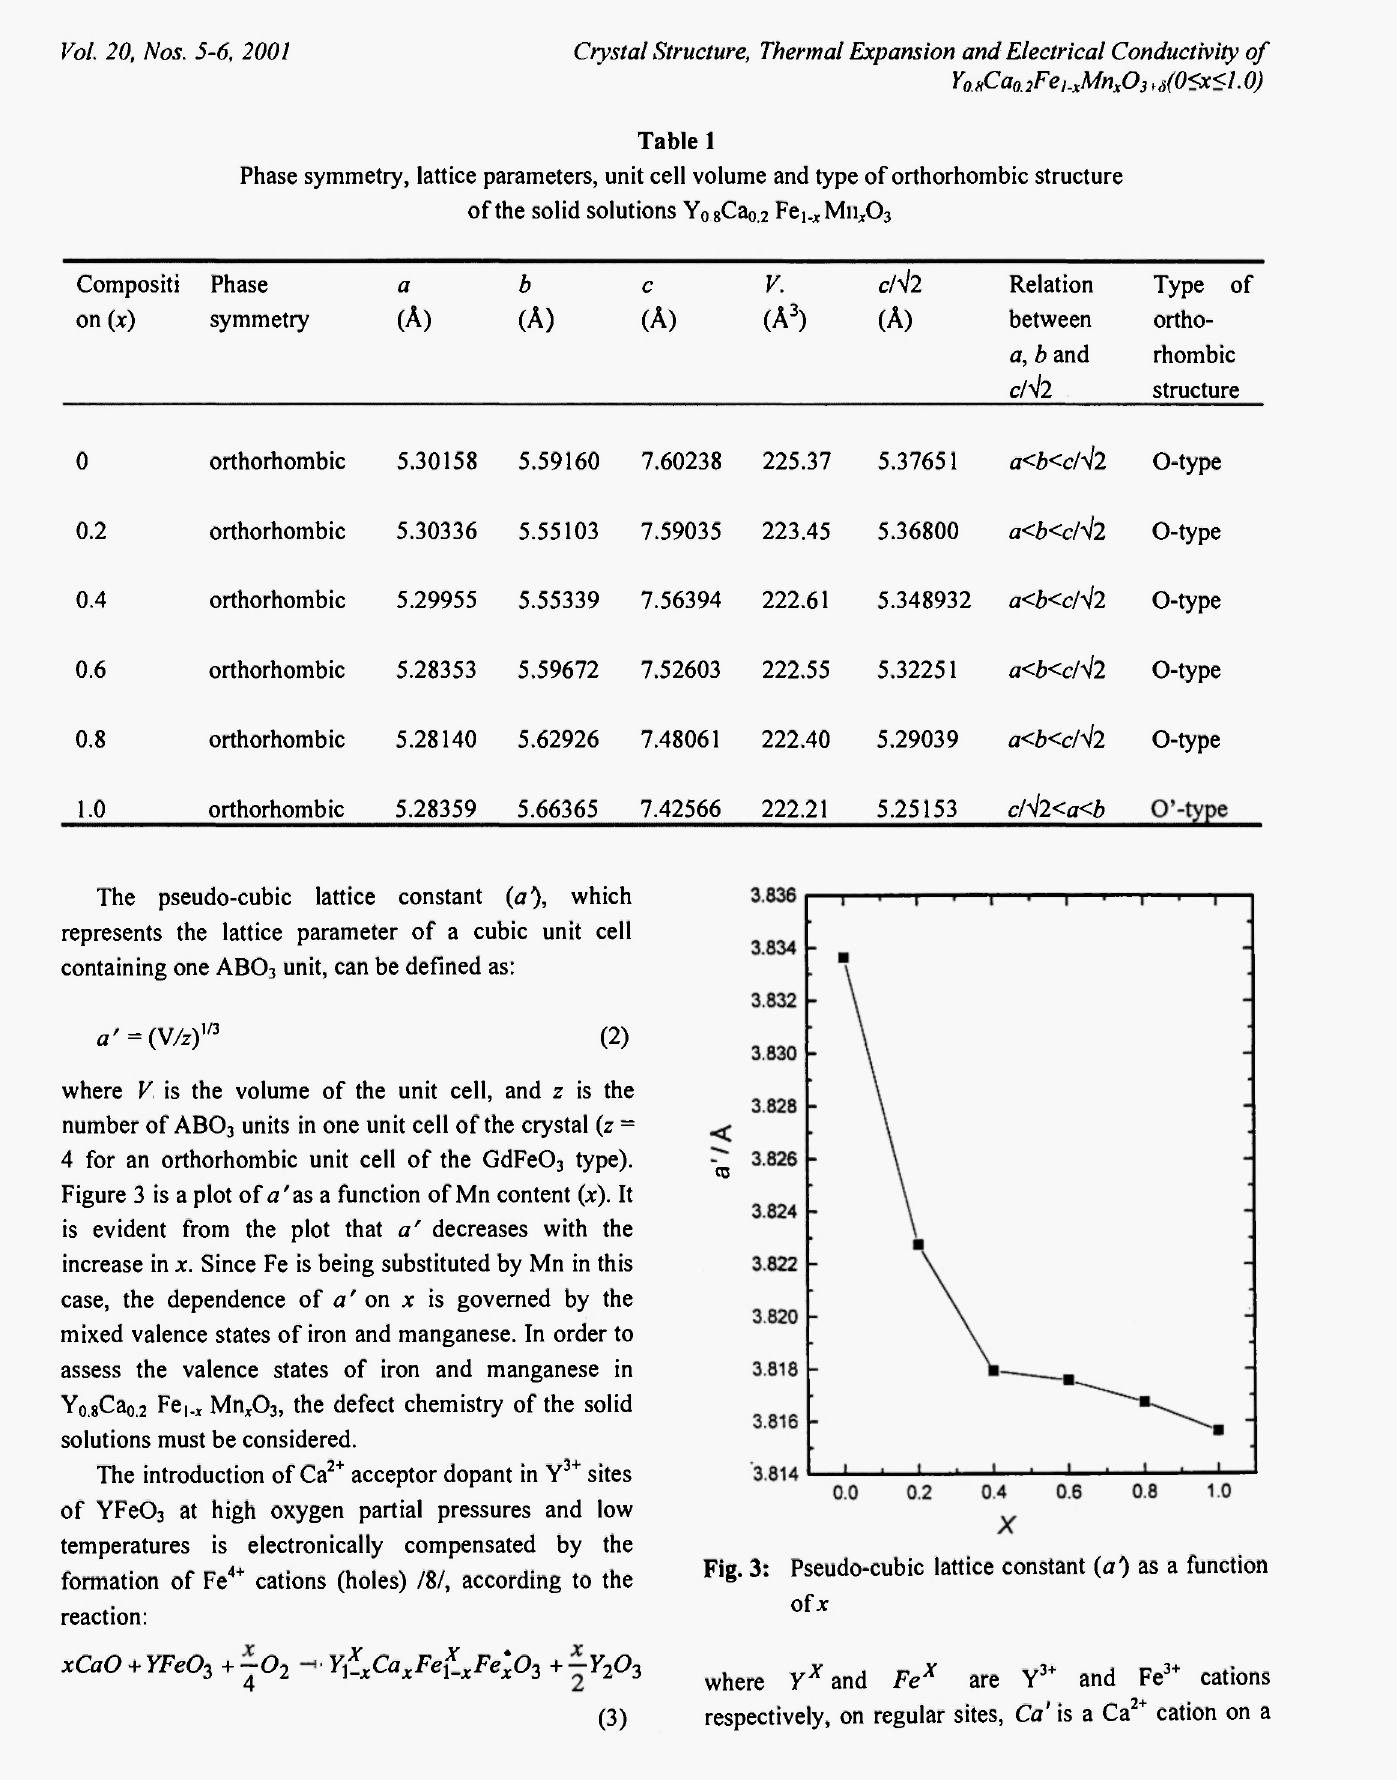
where Y X and Fe X are Y 3+ and Fe 3+ cations respectively, on regular sites, Ca' is a Ca 2+ cation on